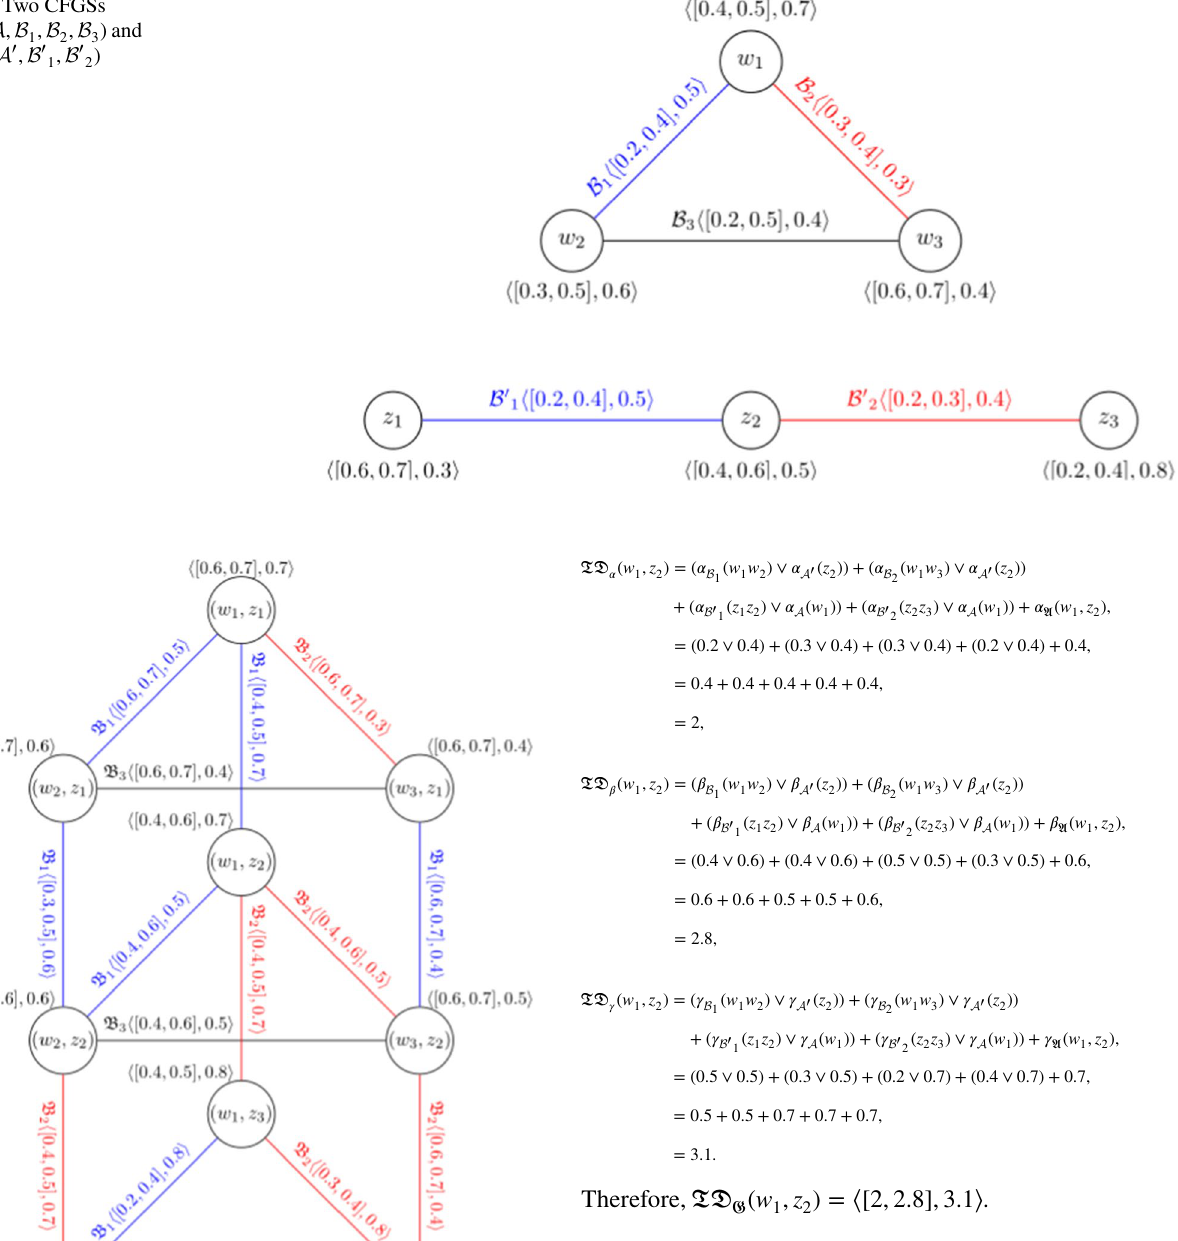
Fig. 8 Two CFGSs G = ( A , B